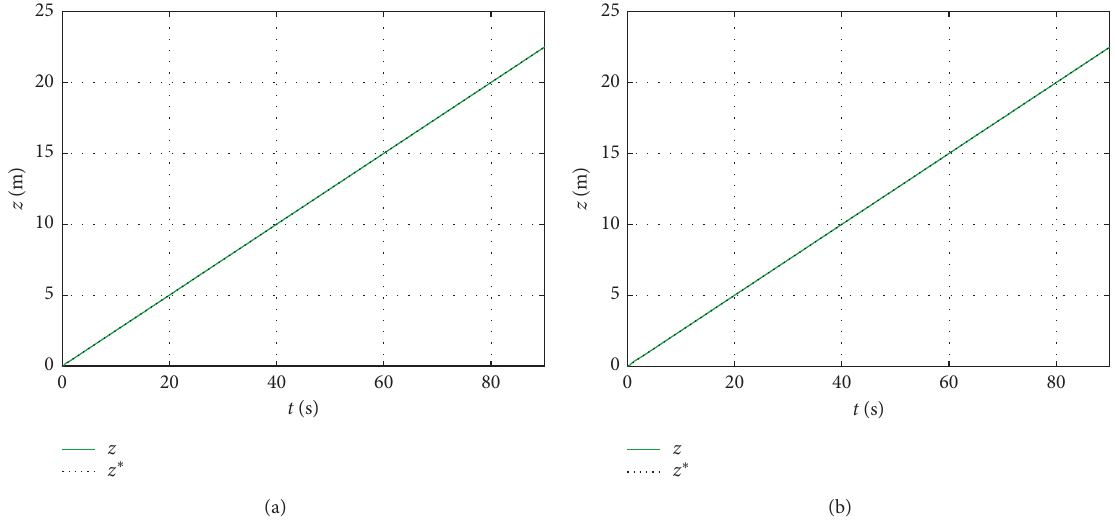
Figure 7: Tracking of planned reference trajectories for Z direction. (a) Trajectory tracking in ( Z ) case 1. (b) Trajectory tracking in ( Z ) case 2.